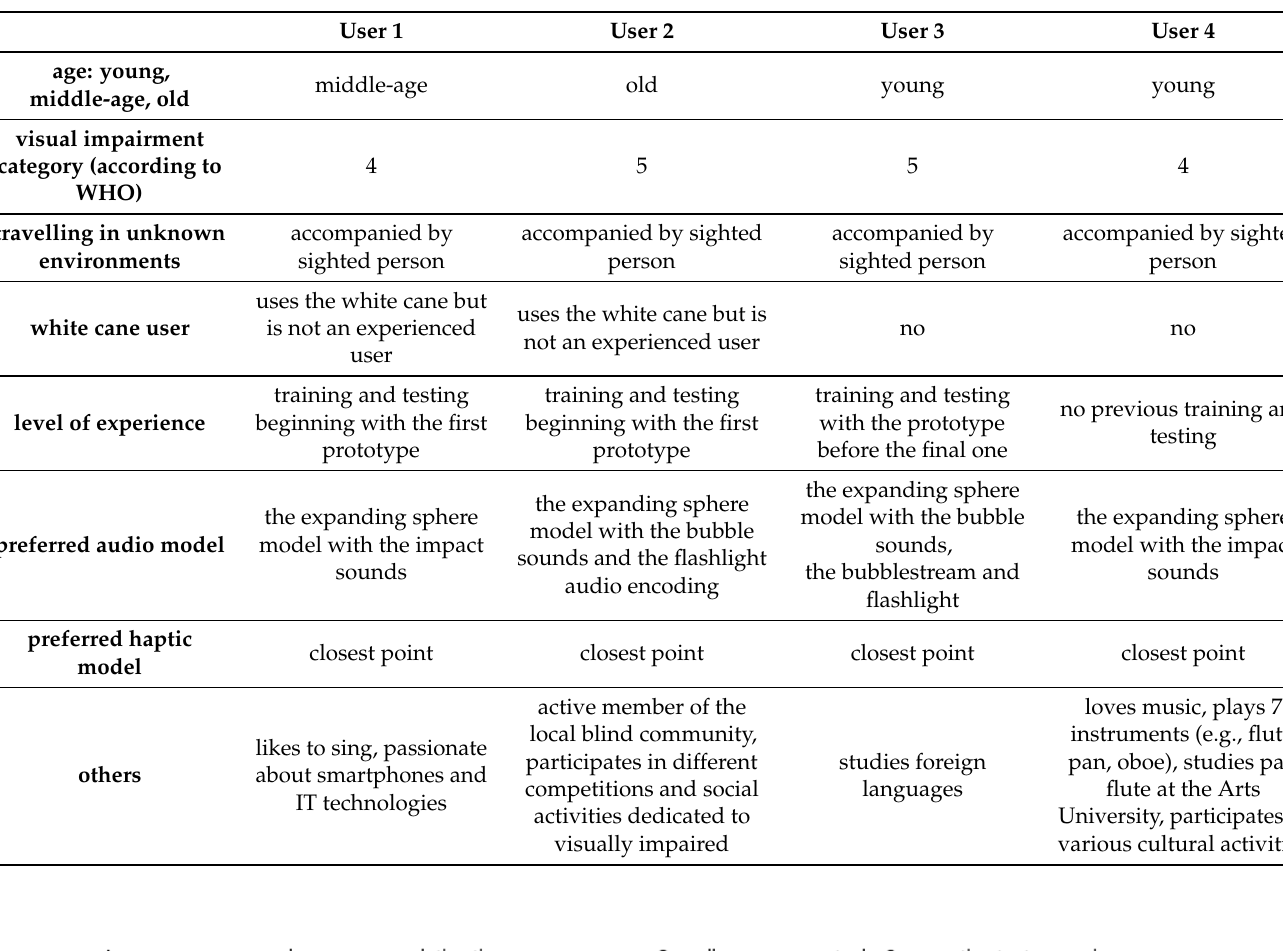
Table 4. Description of the SoV users.